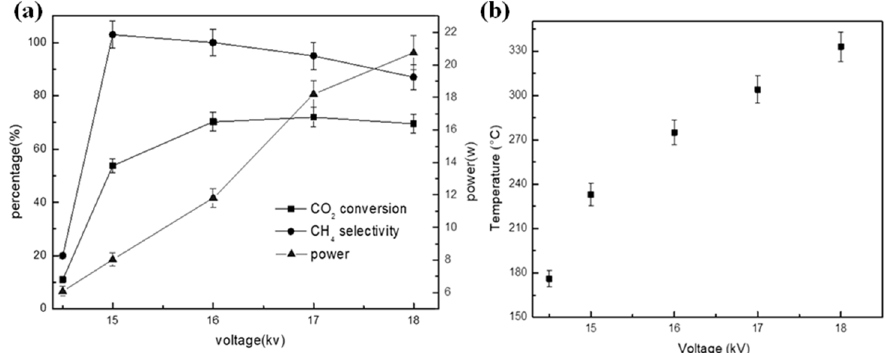
Figure 7. Activity test and voltage impact for the catalysts: ( a ) CO 2 conversion, CH 4 selectivity and power against the voltages. ( b ) Temperature against the voltages. Reprinted with permission from [49]. Copyright 2019 Springer.